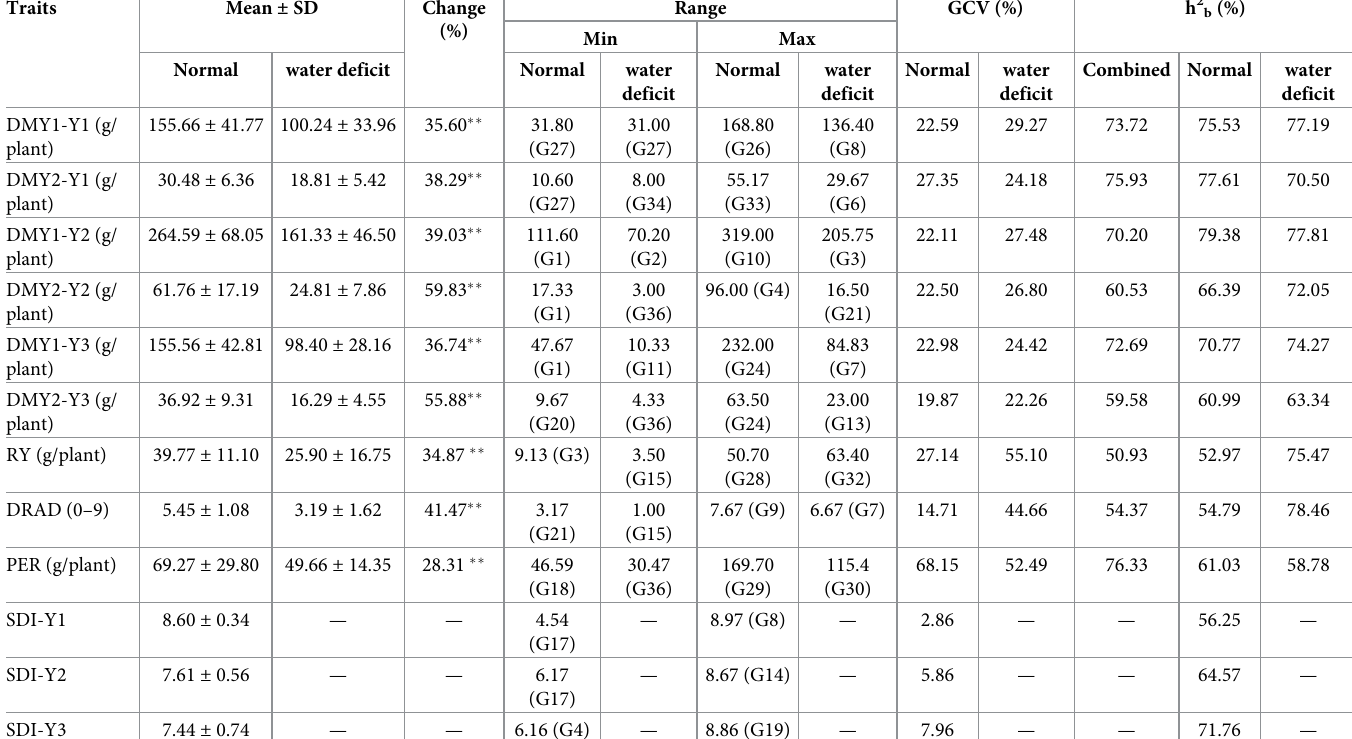
Table 2. Mean performance, range (Min and Max), genotypic coefficient of variation (GCV) and broad- sense heritability (h2b) of traits recorded under normal and water deficit regimes in smooth bromegrass genotypes.